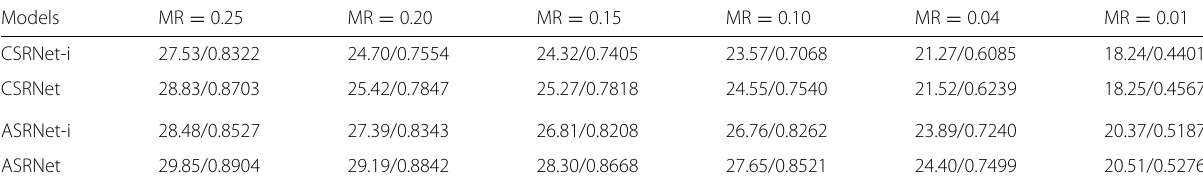
Table 4 The mean PSNR/SSIM values of 11 test images without applying BM3D Models MR = 0.25 MR = 0.20 MR =